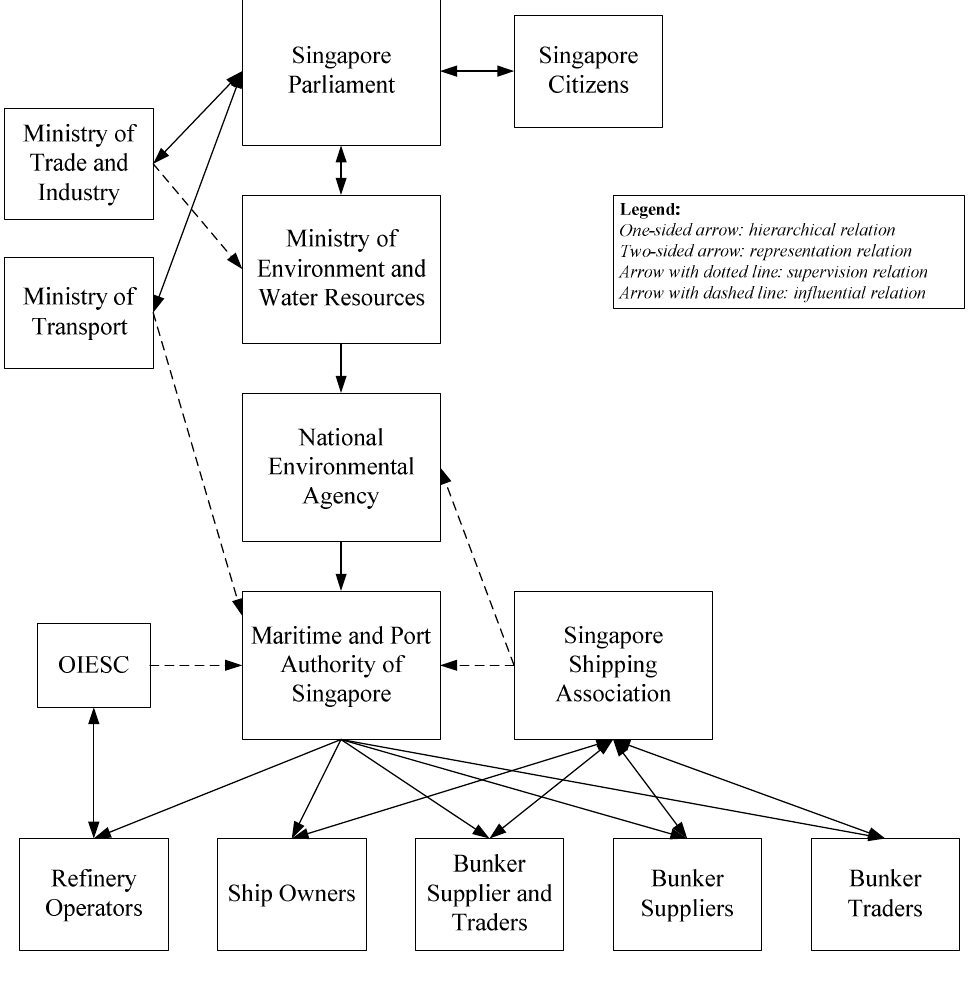
Figure 5. Relations between actors in